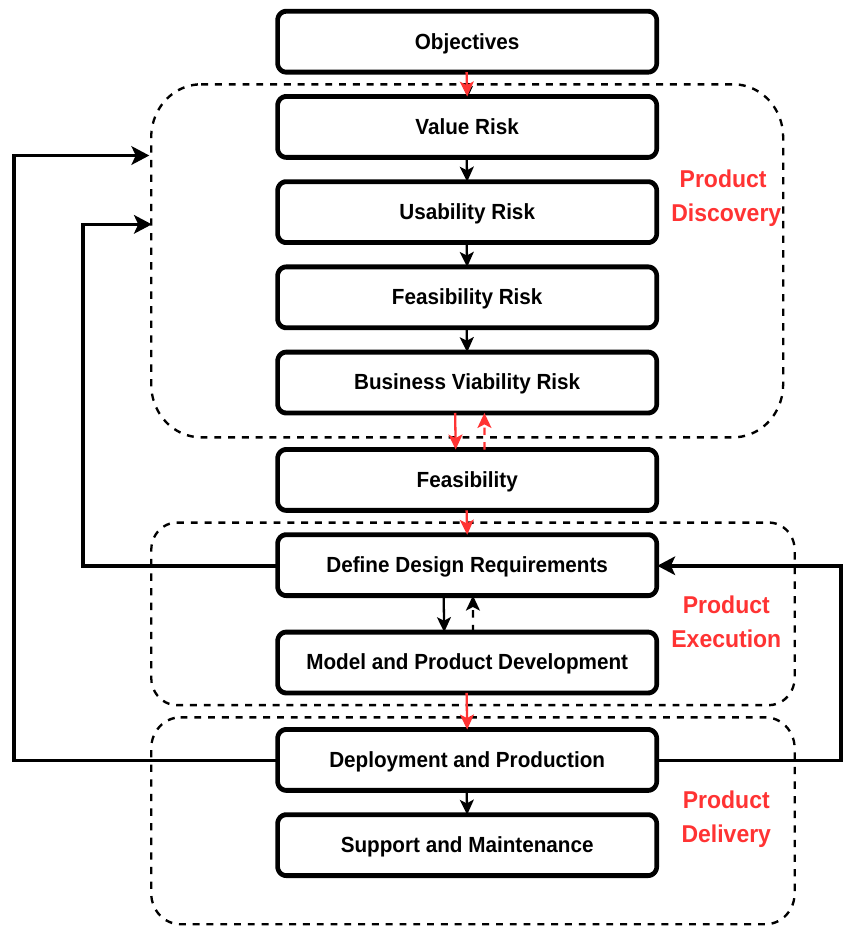
Figure 9. The product development lifecycle for determining feasibility analysis of machine learning projects (adopted from Cagan